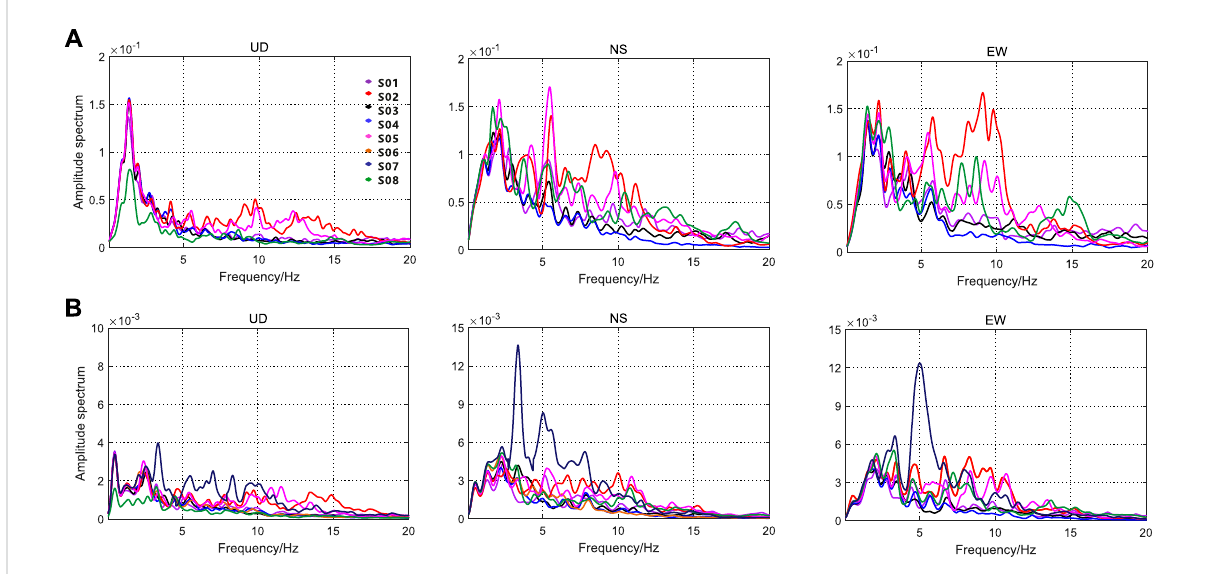
FIGURE 4 Acceleration amplitude spectra of different observation points: (A) amplitude spectra of the Luxian earthquakeand (B) amplitude spectra of the Yibin